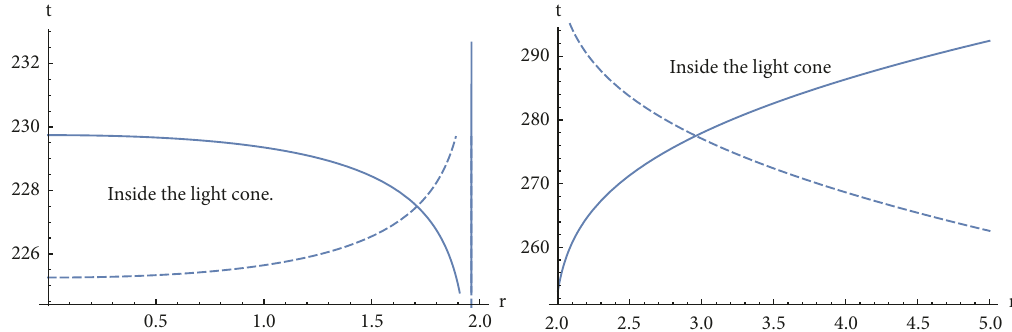
Figure 3: Left: the outgoing (dashed line) and incoming (solid line) geodesics for 𝑟 < 𝑟 𝐻 . Right:tThe outgoing (solid line) and incoming (dashed line) geodesics 𝑟 > 𝑟 𝐻 . The figures are plotted for 𝜆 = 0.1 and 𝑀 = 1